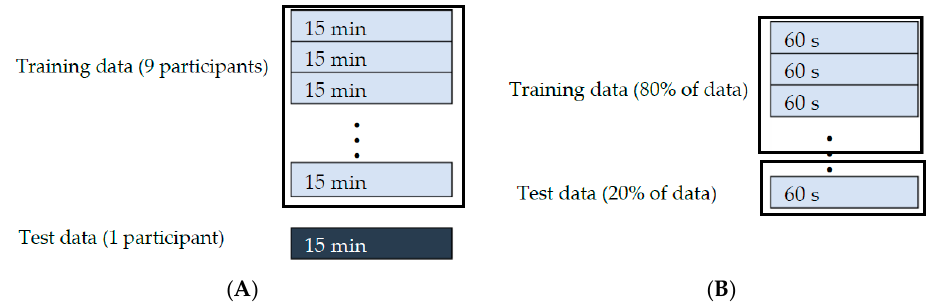
Figure 3. Splitting data for training and testing for ( A ) inter-participant method and ( B ) intra- participant method.